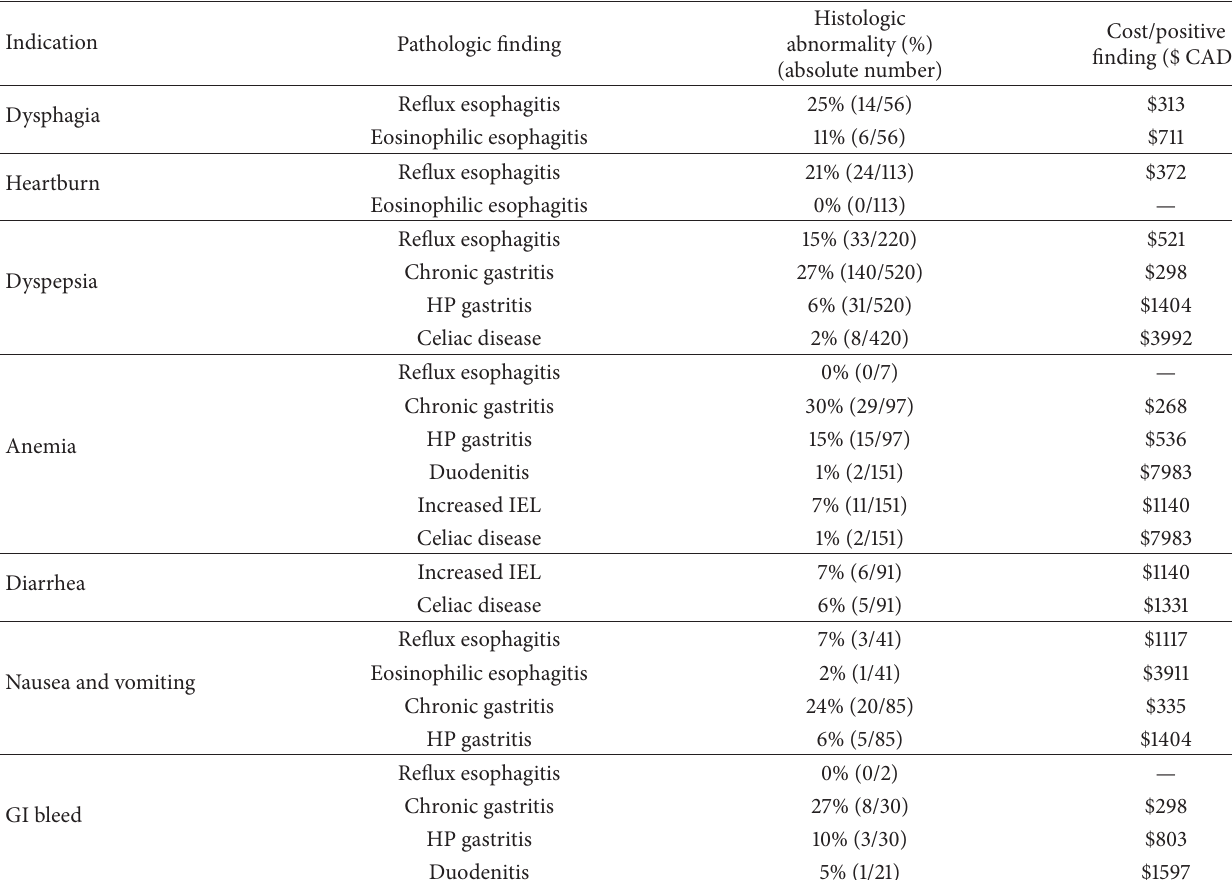
Table 5: Yield of pathologic abnormality and cost per positive finding on macroscopically normal EGDs based on the clinical indication.